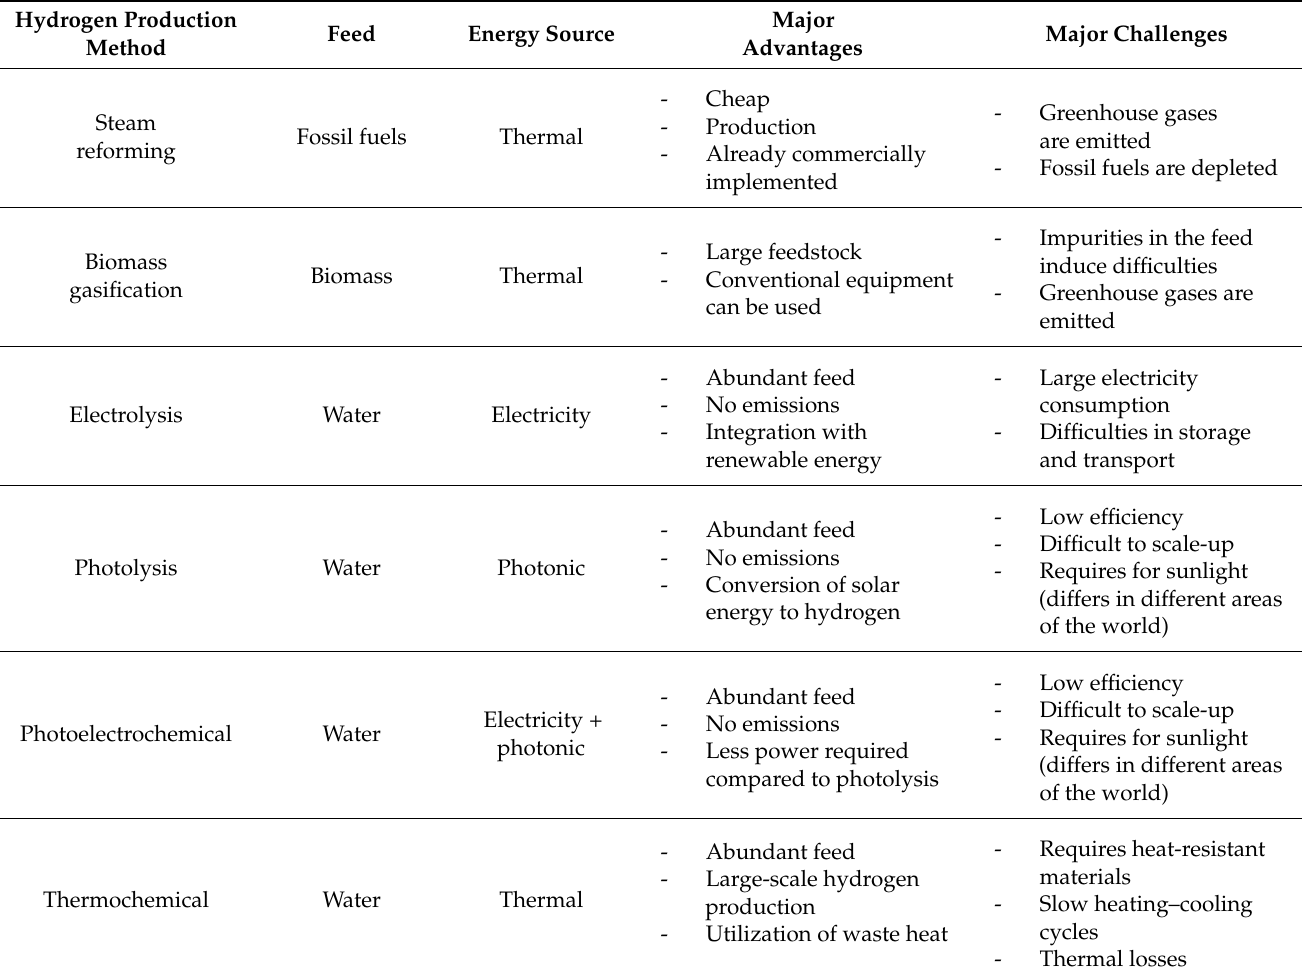
Table 1. Overview of hydrogen production methods, including the feed, energy source and major advantages and